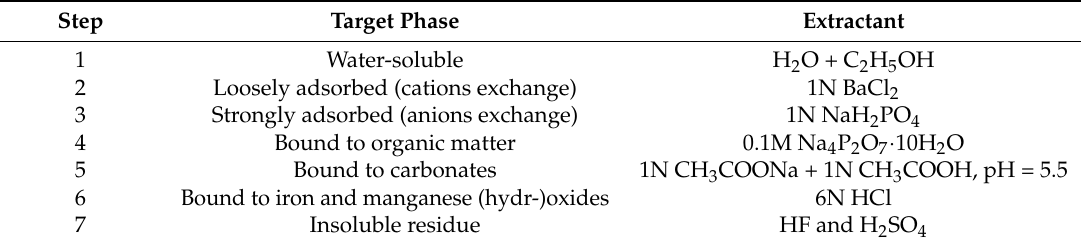
Table 3. Sequential extraction